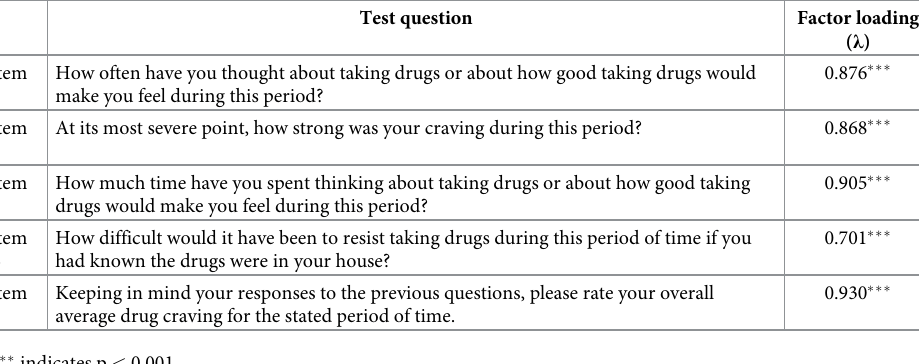
Table 2. Standardised factor loadings: Confirmatory factor